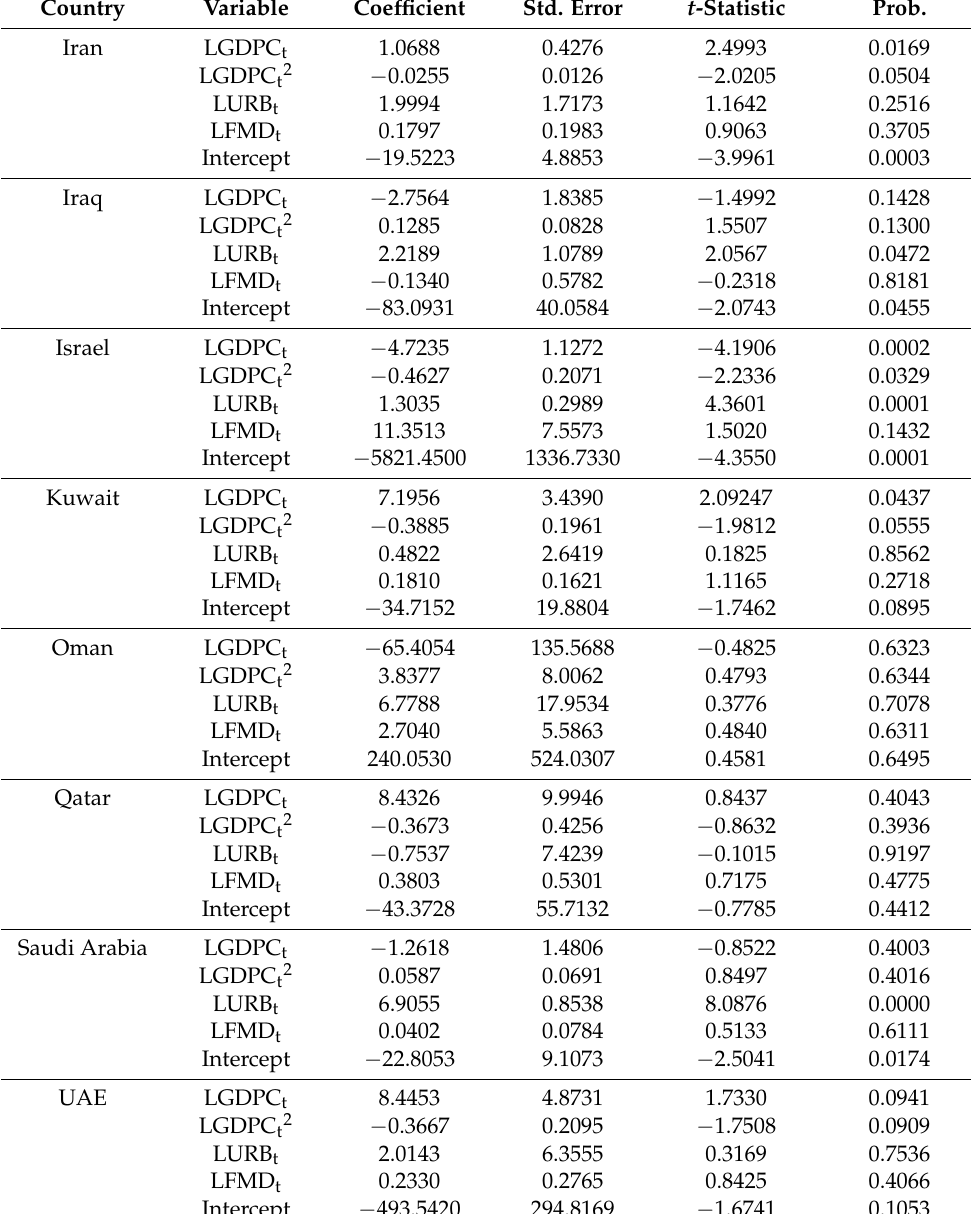
Table 2. Long-run results: LNGC t as the dependent